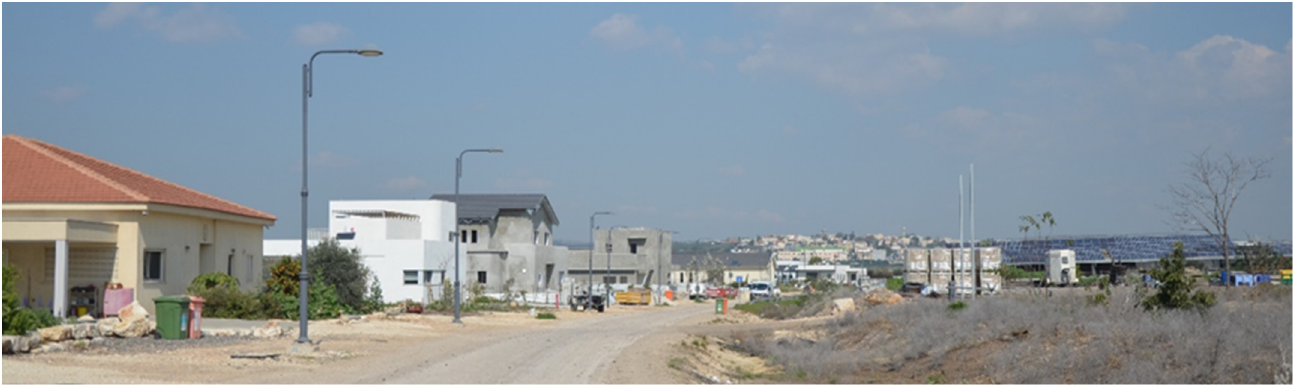
Figure 12. Open vista between residential homes in Nahalal. Photo by the authors.